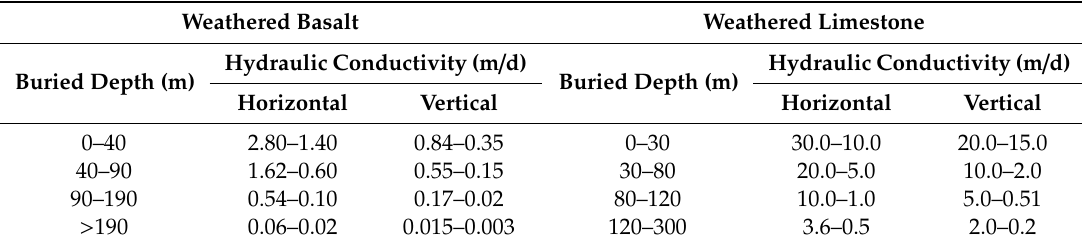
Table 4. Hydraulic conductivity of the weathered zone in the river valley.